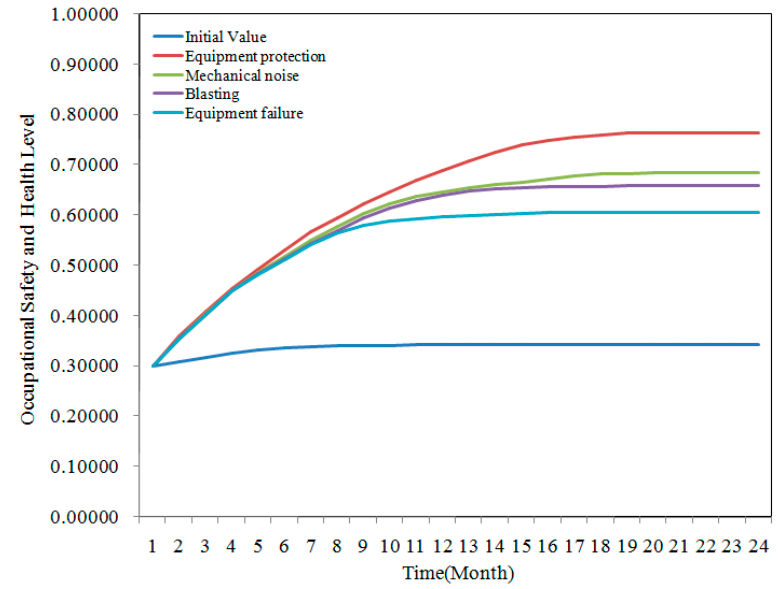
Figure 8. SD simulation of machine factor measures.